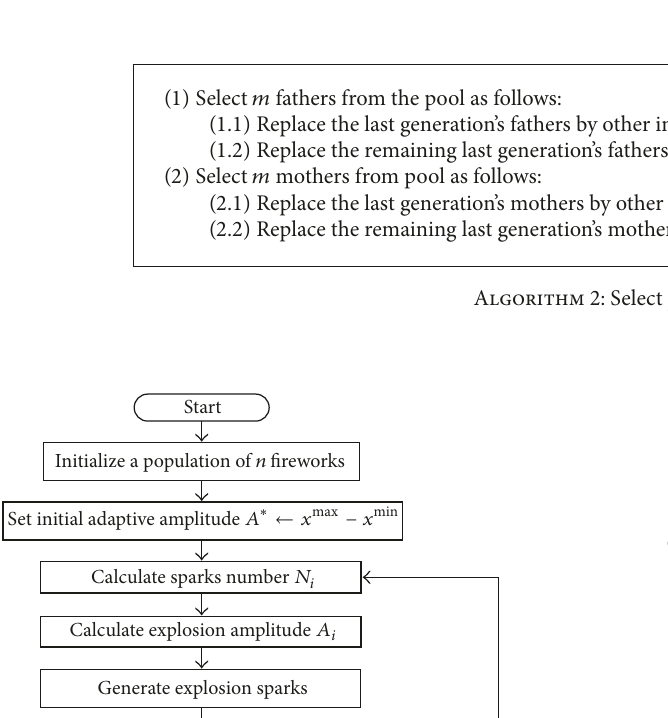
Algorithm 1: Construct the recombination pool.